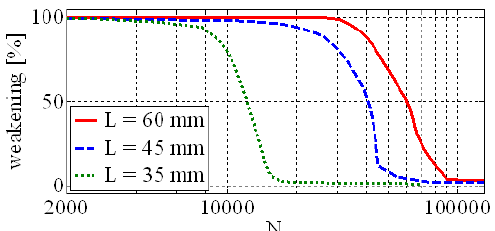
Figure 10. Performance degradation with a growing number of cy- cles for the different height adjustments of the fatigue test bench (at 5Hz).